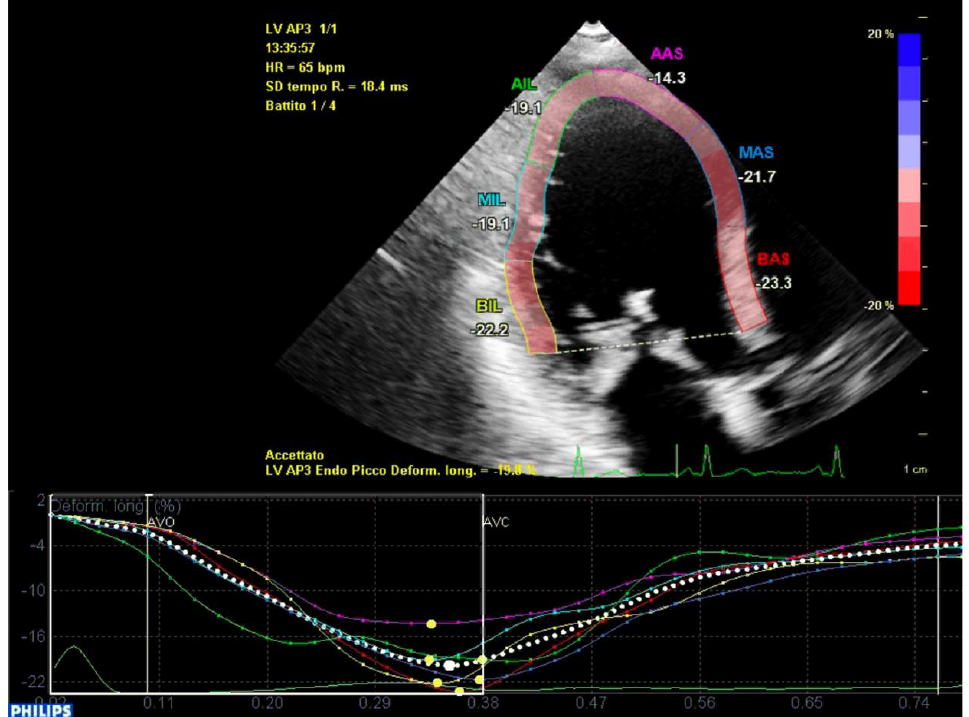
Figure 9. Global longitudinal strain in a patient from the A-MVP group. Mechanical dispersion is lower as peak systolic shortening times present lower variability.